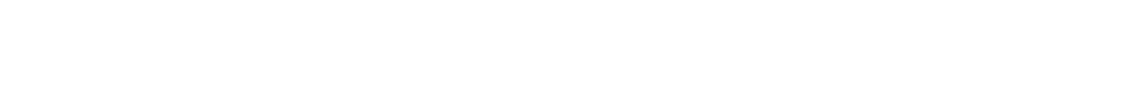
FIGURE 4 | Major changes between pre- and post-surgery for the dorsal DMN (A) or the ventral DMN (B), within each patient group. The images are shown in radiological orientation (e.g., the right side is the left hemisphere). LH, left hemisphere; RH, right